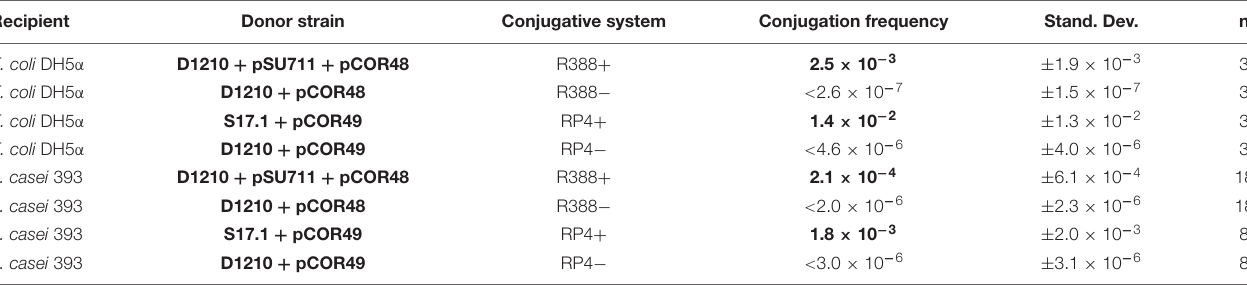
TABLE 4 | Conjugation frequency of mobilizable shuttle plasmids into E. coli and Lacticaseibacillus casei 393. Recipient Donor